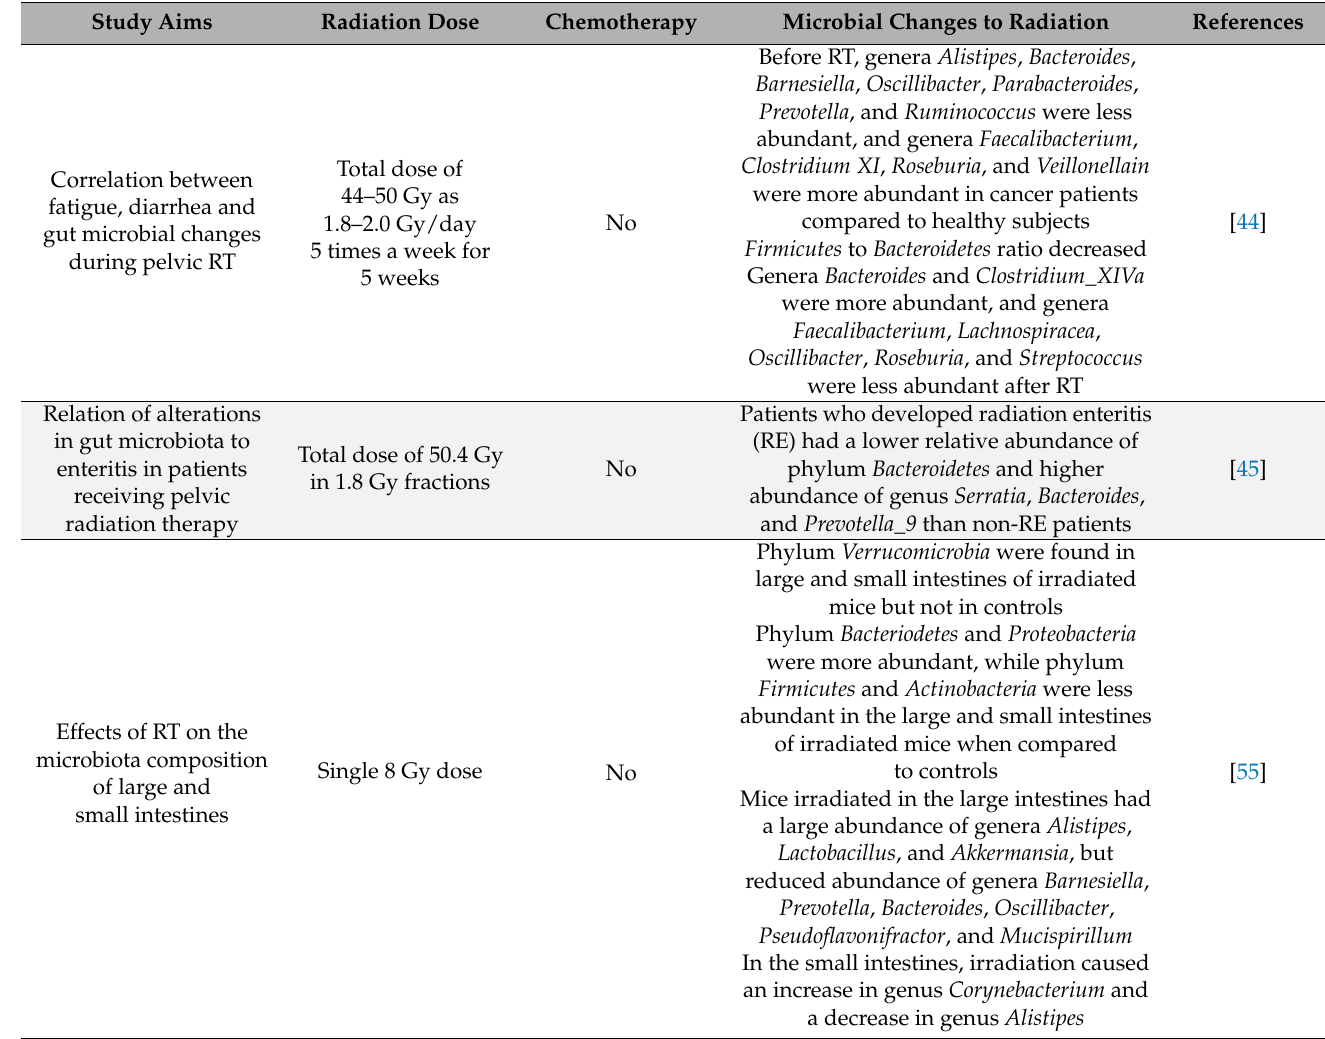
Table 1. Radiation therapy-induced changes in the gut